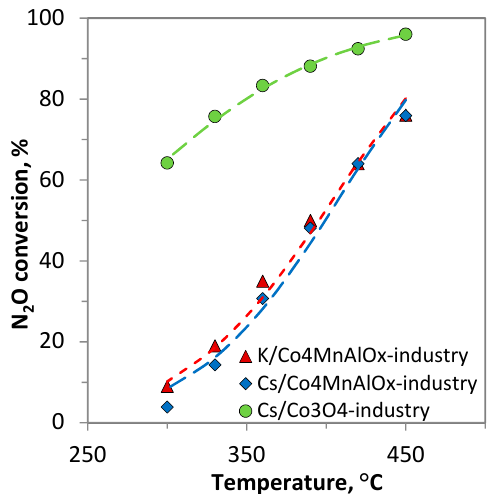
Figure 2. N 2 O catalytic decomposition over industrially prepared catalysts (tablets 5 mm × 5 mm) tested in laboratory conditions. Points—experimental data; dashed line—model (Equation 2).